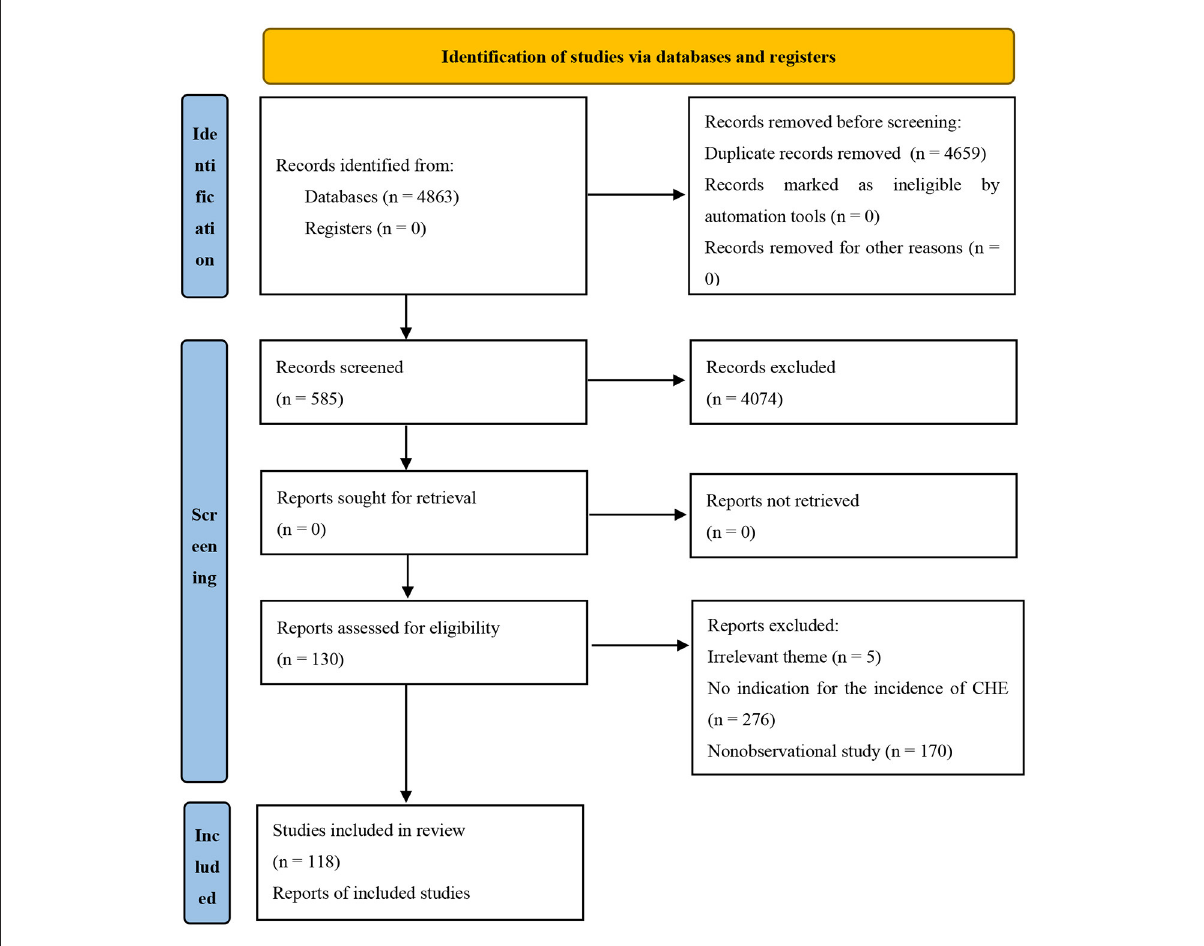
FIGURE1 Flow chart of study